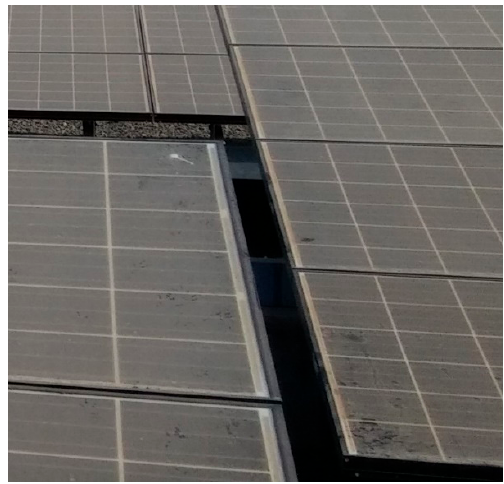
Figure 1. Soiling causes significant losses in the power output of solar modules.